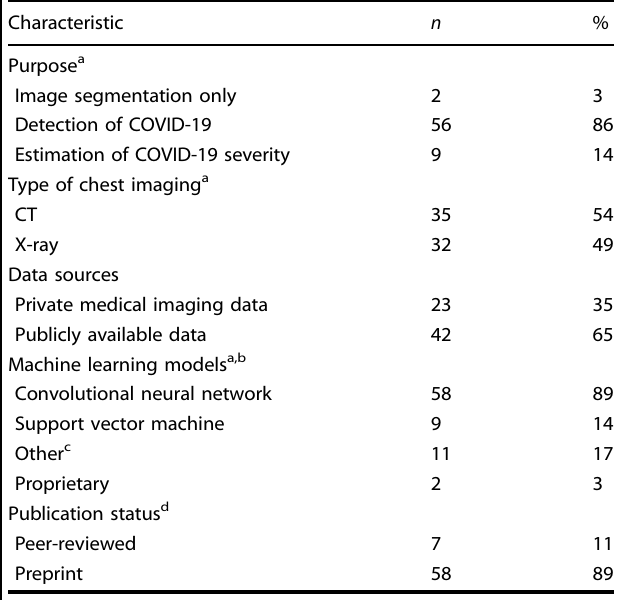
Table 4. Characteristics of studies that developed machine learning- based algorithms and tools for COVID-19 diagnosis or estimation of disease severity based solely on chest imaging ( n = 65). Characteristic